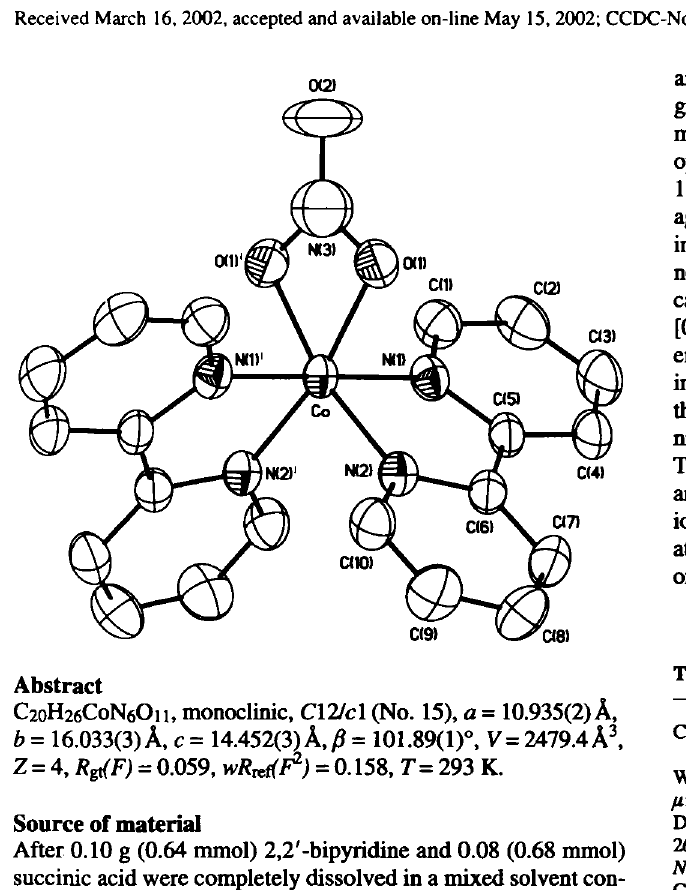
Table 1. Data collection and handling.